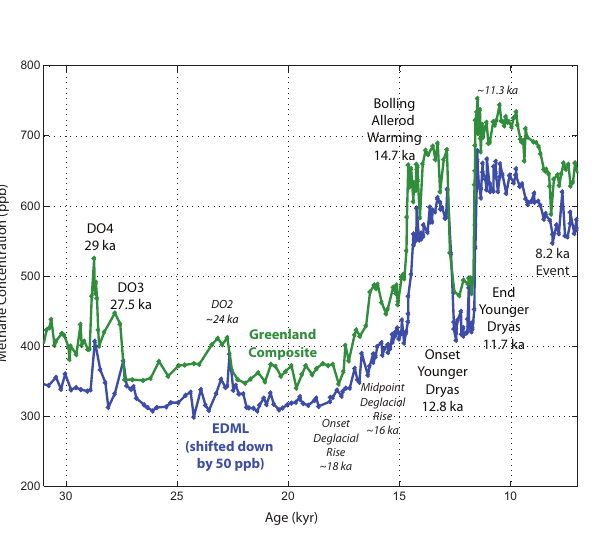
Figure 1. Commonly used methane tie points between 8 and 30kyr. Italicized match points indicate less certain correlations. Greenland Composite Methane on GICC05 and EDML Methane on timescale of Lemieux-Dudon et al.